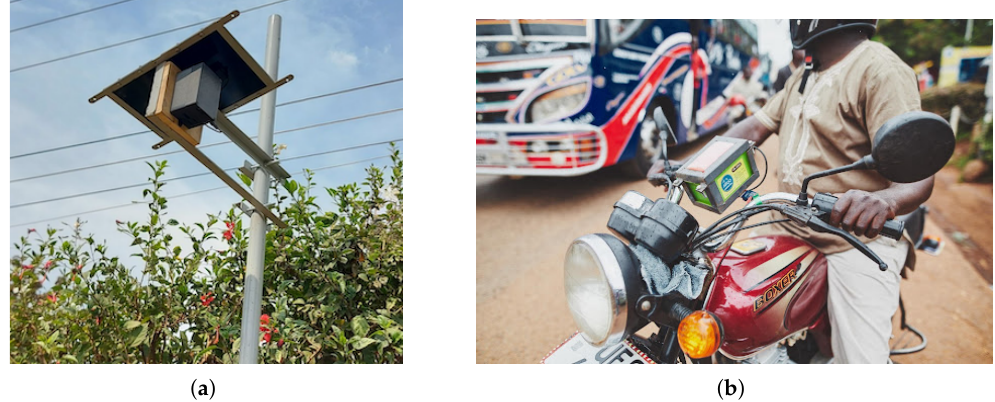
Figure 3. Flexible deployment options for high resolution air quality sensing. ( a ) Static pole deploy- ment. ( b ) Mobile